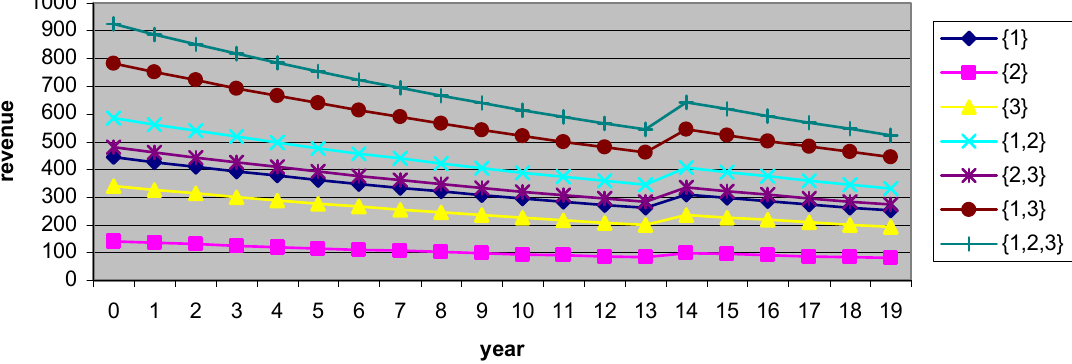
Figure 2. Annual revenues for coalitions in games v tA0 for t = 0, …, 19 under Alternative A0 (from the data shown in Table A5 in Appendix A). After Year 13, alternative A0 produces a negative net benefit (i.e., the revenues minus the costs) under the reference cropping pattern in Table 2 (Scenario A0) and farmers are supposed to switch the cropping pattern in Table 2 (Scenario A2).